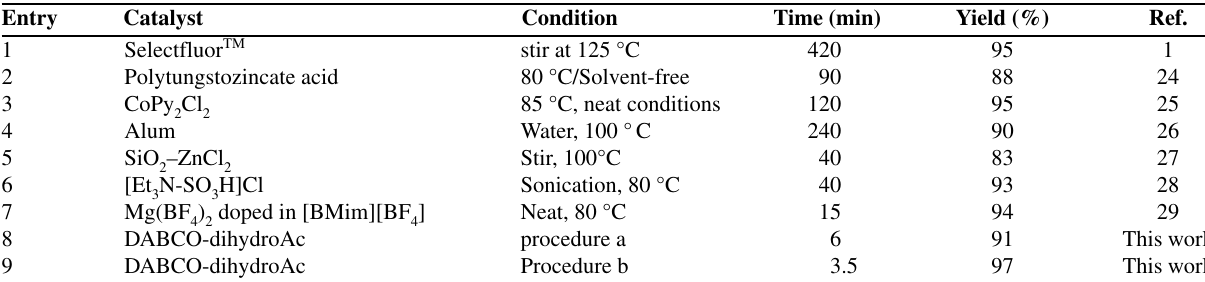
Table 4. Comparison of synthesis of compound 3b in this method with some of the previously reported